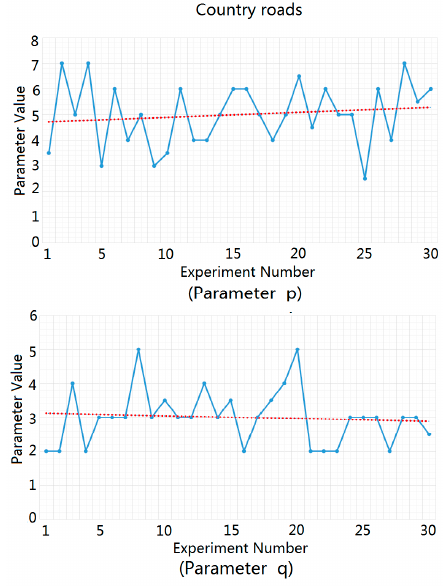
Figure 9. Solution process of parameters p and q for rural roads.